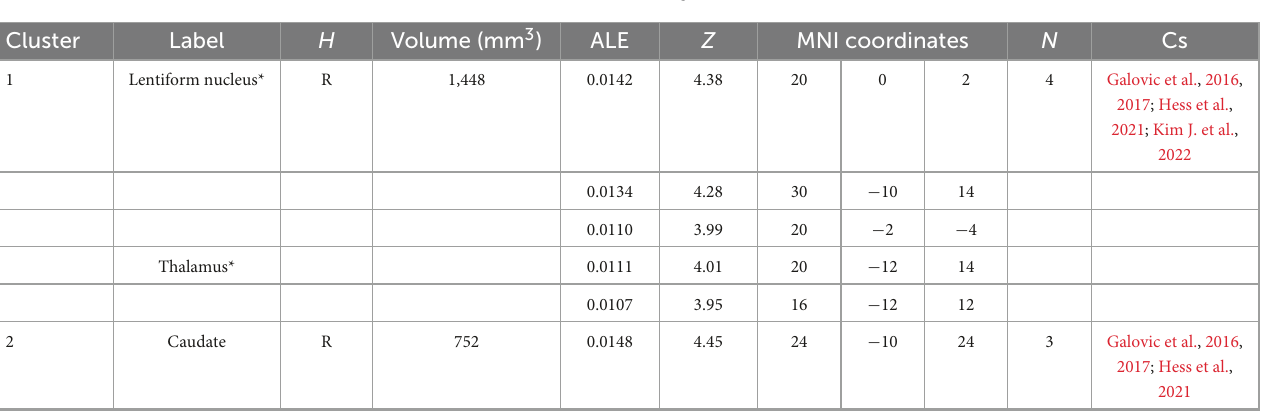
TABLE 3 Clusters of structural MRI activation likelihood estimation (ALE)